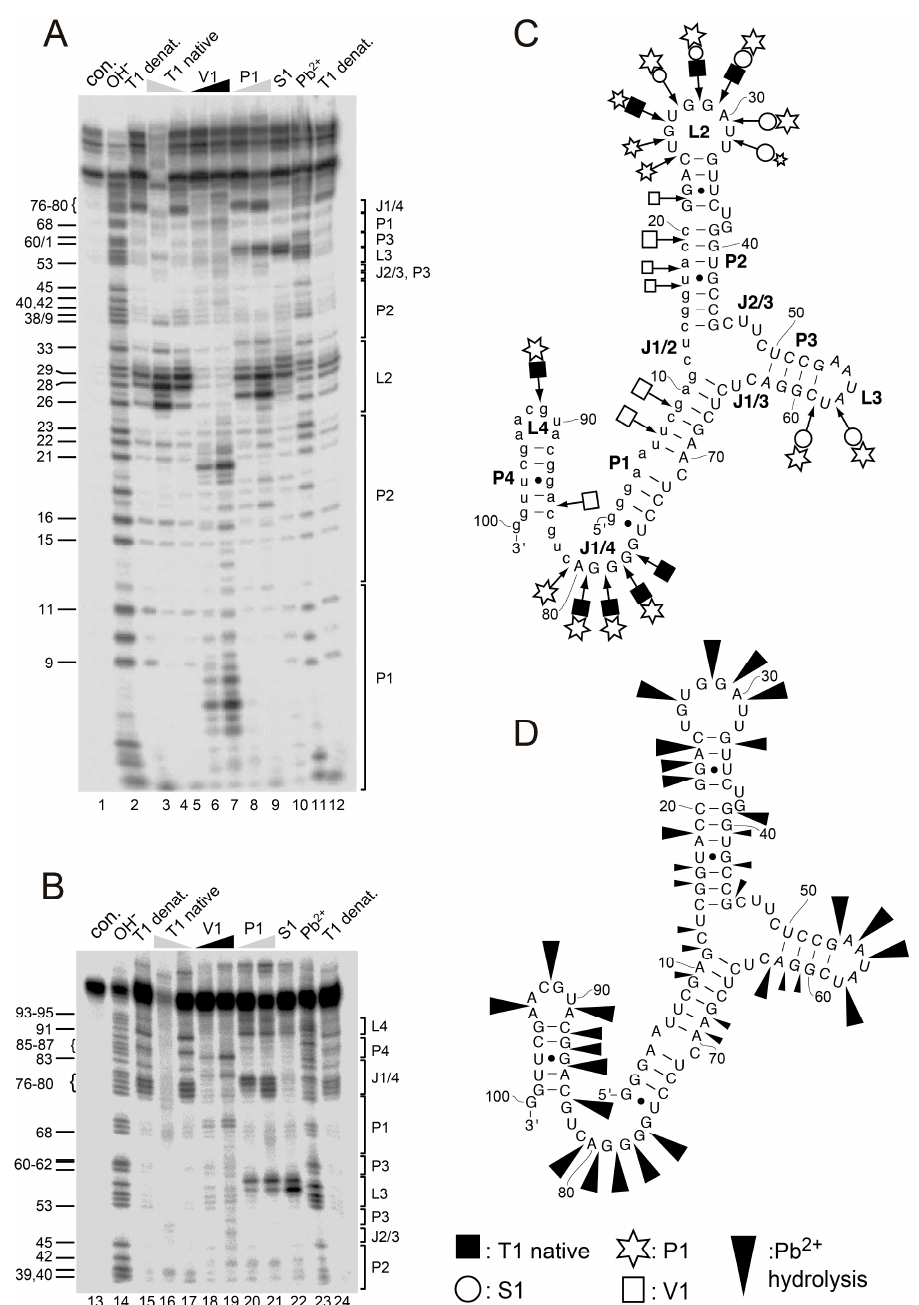
Figure 3. Representative probing experiments using 5 ′ -endlabeled aptamer A011 RNA and analyzed by ( A ) 20% or ( B ) 10% denaturing PAGE. Lanes 1 and 13, undigested RNA control (con.); lanes 2 and